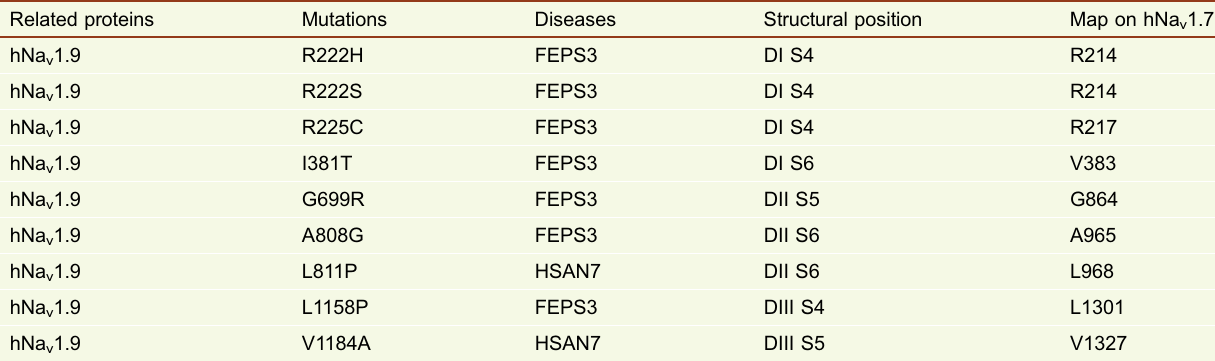
Table 9. Structural mapping of disease-related mutations identi fi ed in human Na v 1.9 Related